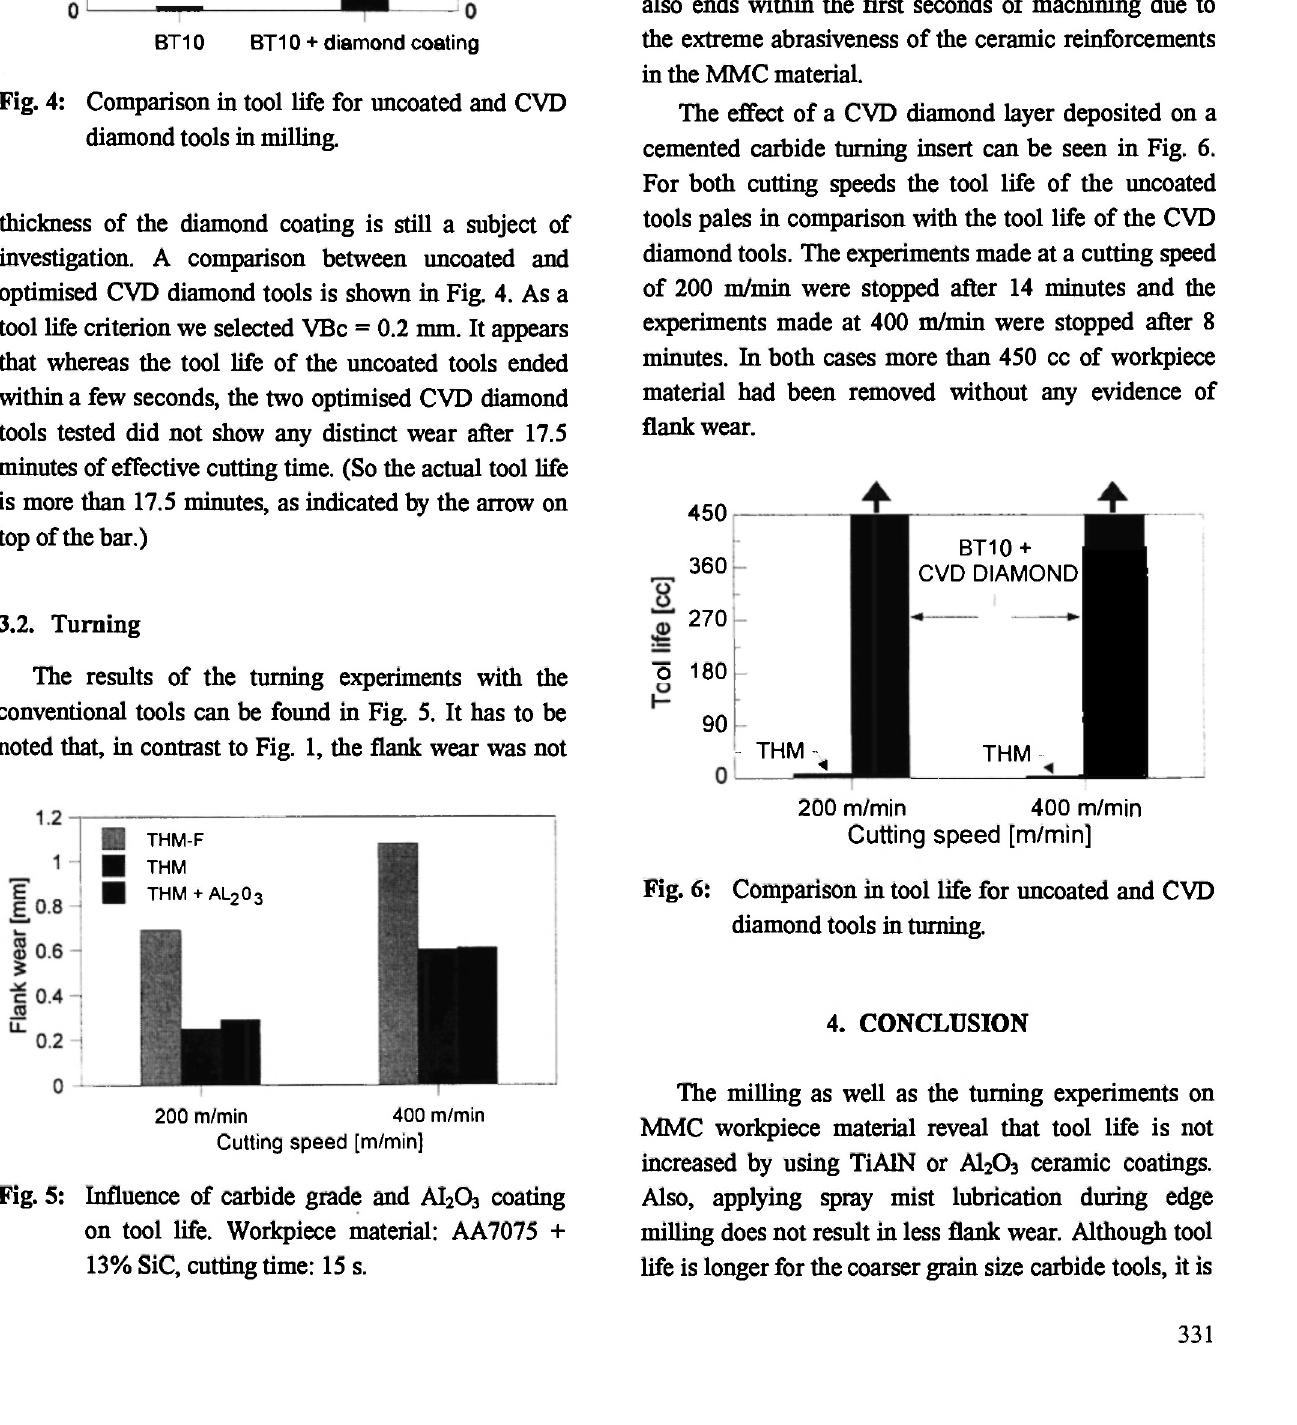
Fig. 4: Comparison in tool life for uncoated and CVD diamond tools in milling.